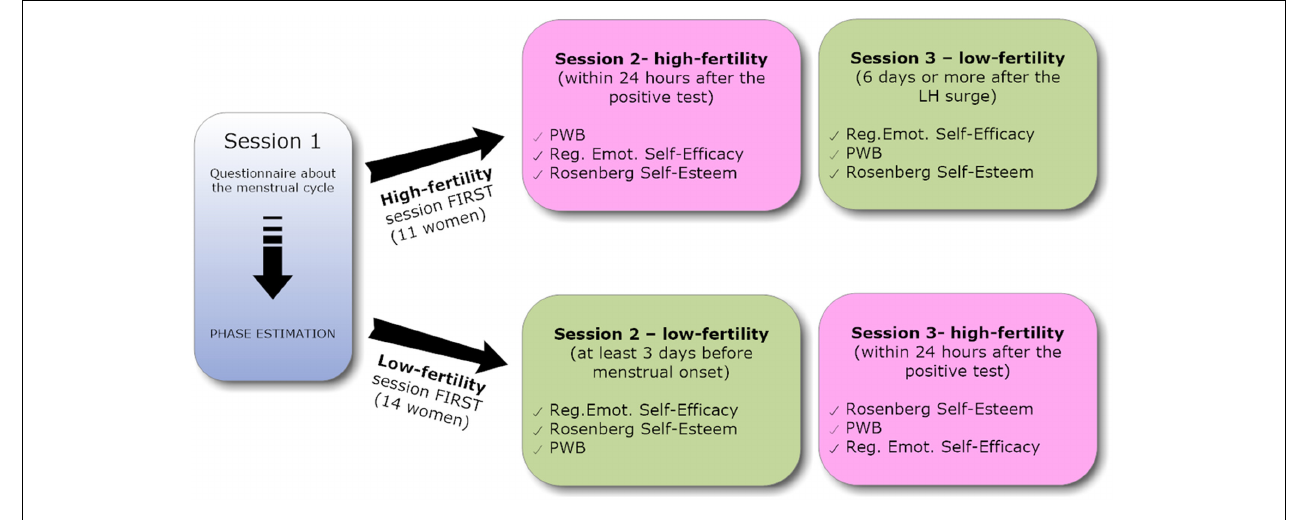
FIGURE 1 | Design of the